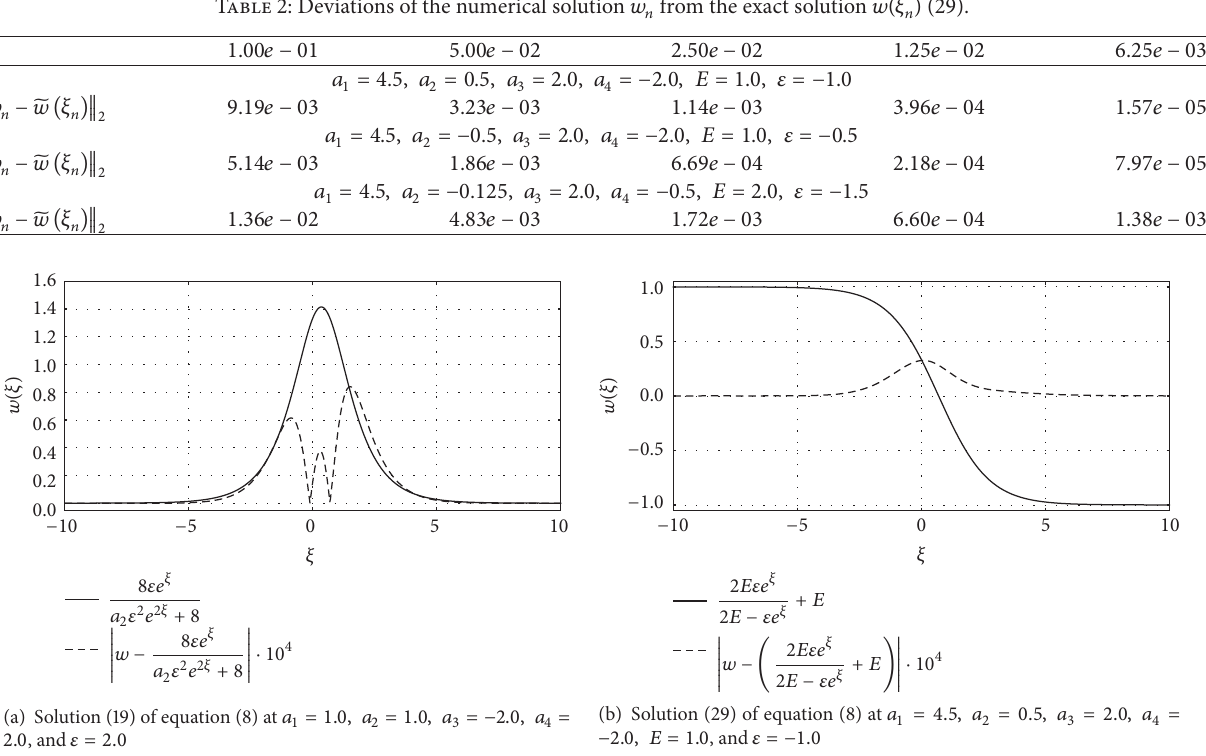
(a) Solution (19) of equation (8) at 𝑎 1 = 1.0, 𝑎 2 = 1.0, 𝑎 3 = −2.0, 𝑎 4 = 2.0 , and 𝜀 = 2.0 Figure 3: The exact solution (solid line) and error of the numerical solution multiplied by 10 4 (dashed line). 𝑤 𝑘+1 = ̃𝑤 (𝜉 − ℎ) 0 𝑁−2